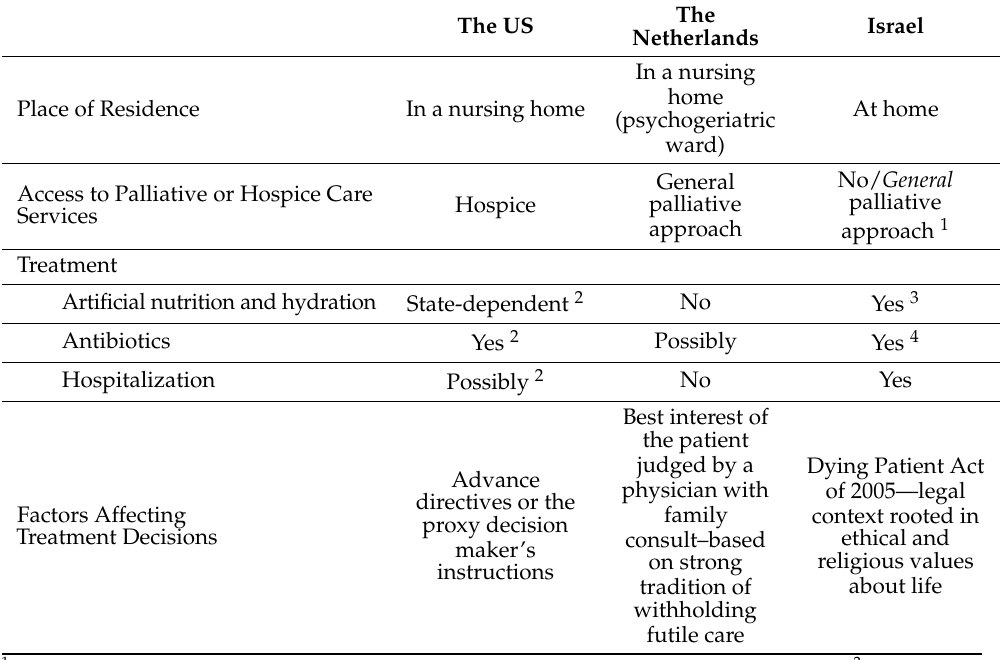
Table 1. Care of a person with advanced dementia in the US, The Netherlands, and Israel as inferred from the literature and (in italics) possible revisions from the expert consultation independent from the literature